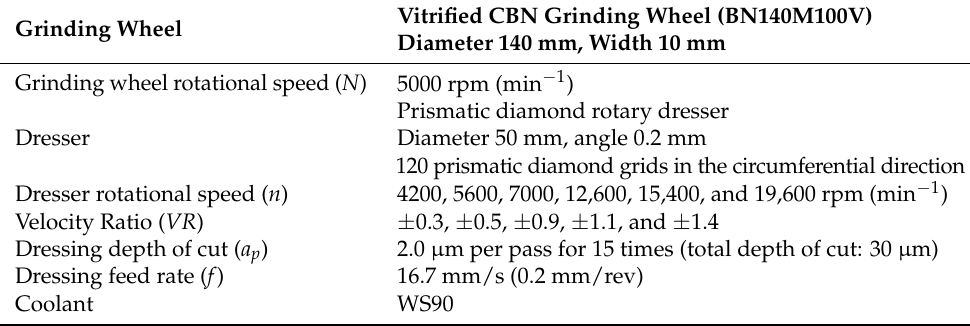
Table 1. Grinding wheel and other